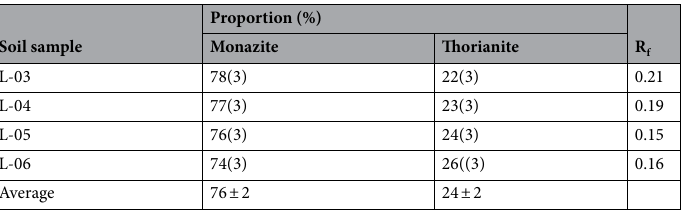
Table 1. Linear combination fitting results for the soil samples Th L 3 -edge EXAFS spectra (2.9 < k < 10.5 Å -1 ). Uncertainties are indicated in parentheses. The absolute misfit between modeled and experimental data is indicated by the R f